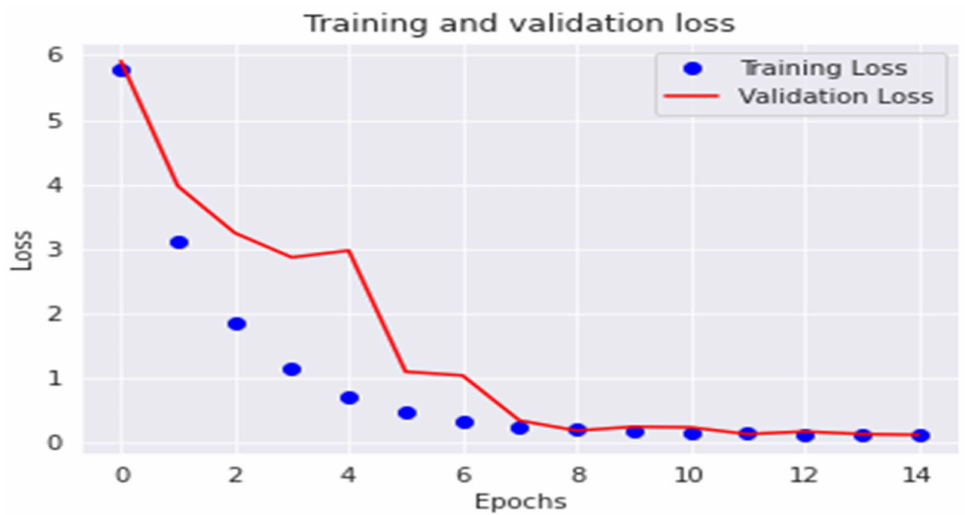
Figure 9. The ResNet101 model loss vs. epoch numbers.